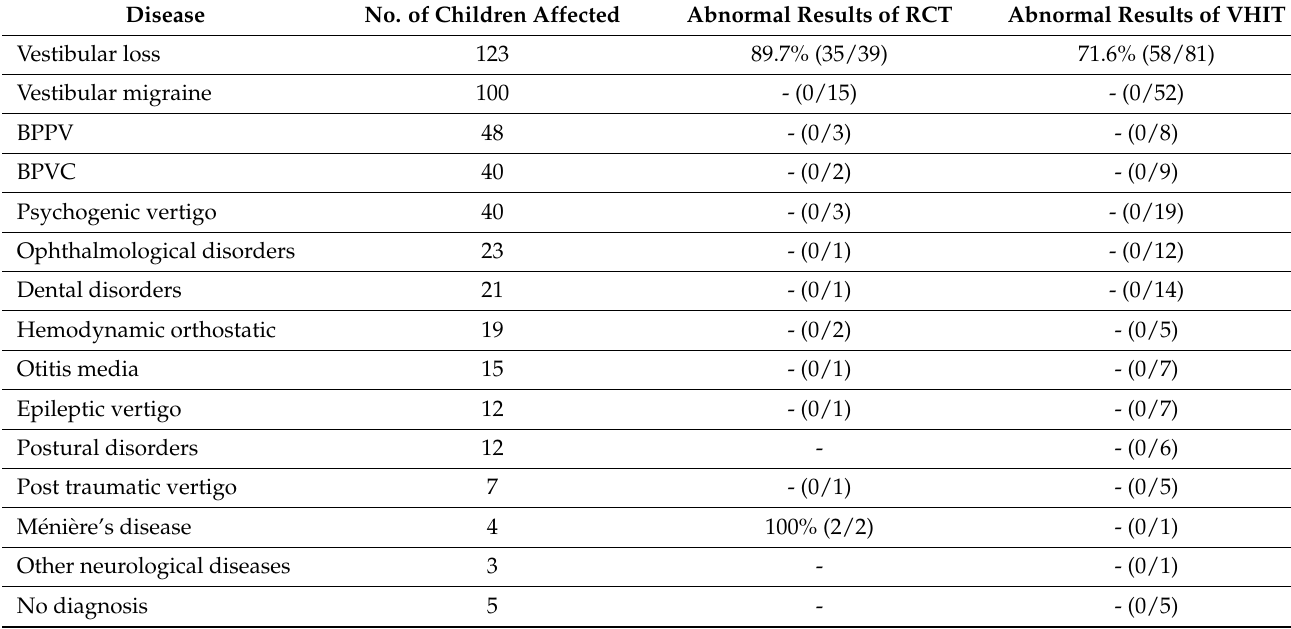
Table 4. Percentage of abnormal results of RCT and VHIT according to cause of vertigo in children (No. of positive test/No. of children tested is reported in